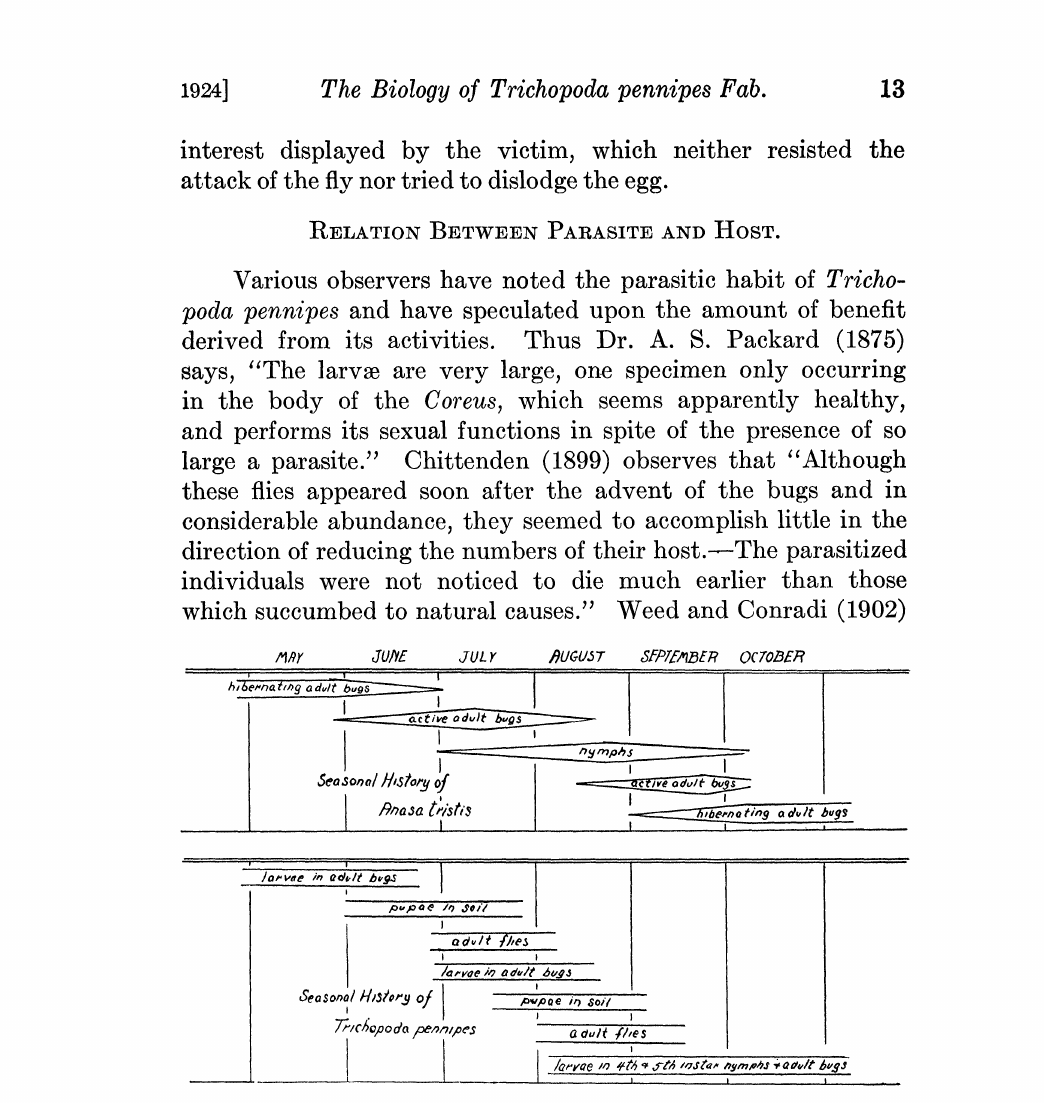
Fig. 1. l.elation of Trichopoda Pennipes to its host, Anasa tristis, Amherst, Massa- chusetts, 1922. Worthley